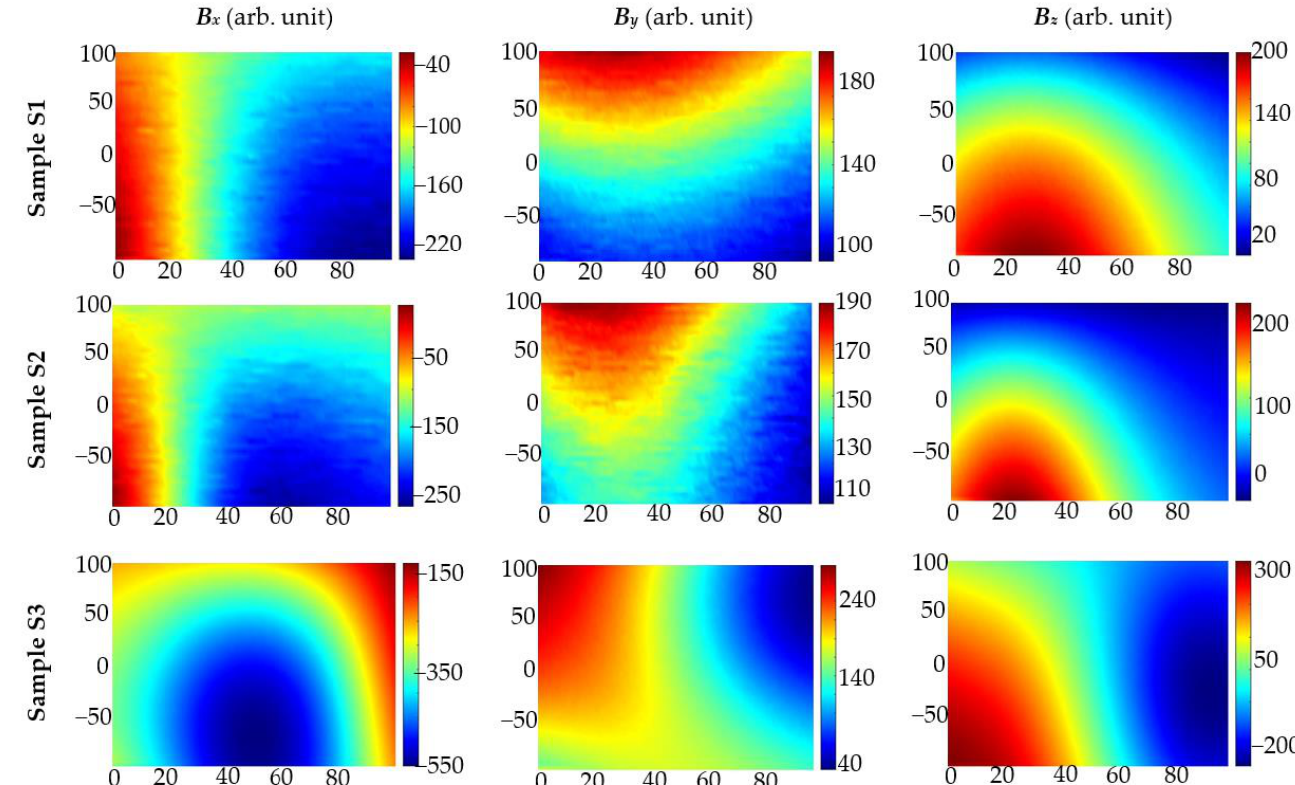
Figure 20. Graphs of the normalized value of the magnetic field component B x ( x ) as a function of the concrete cover thickness h (mm) obtained for various magnetization methods.